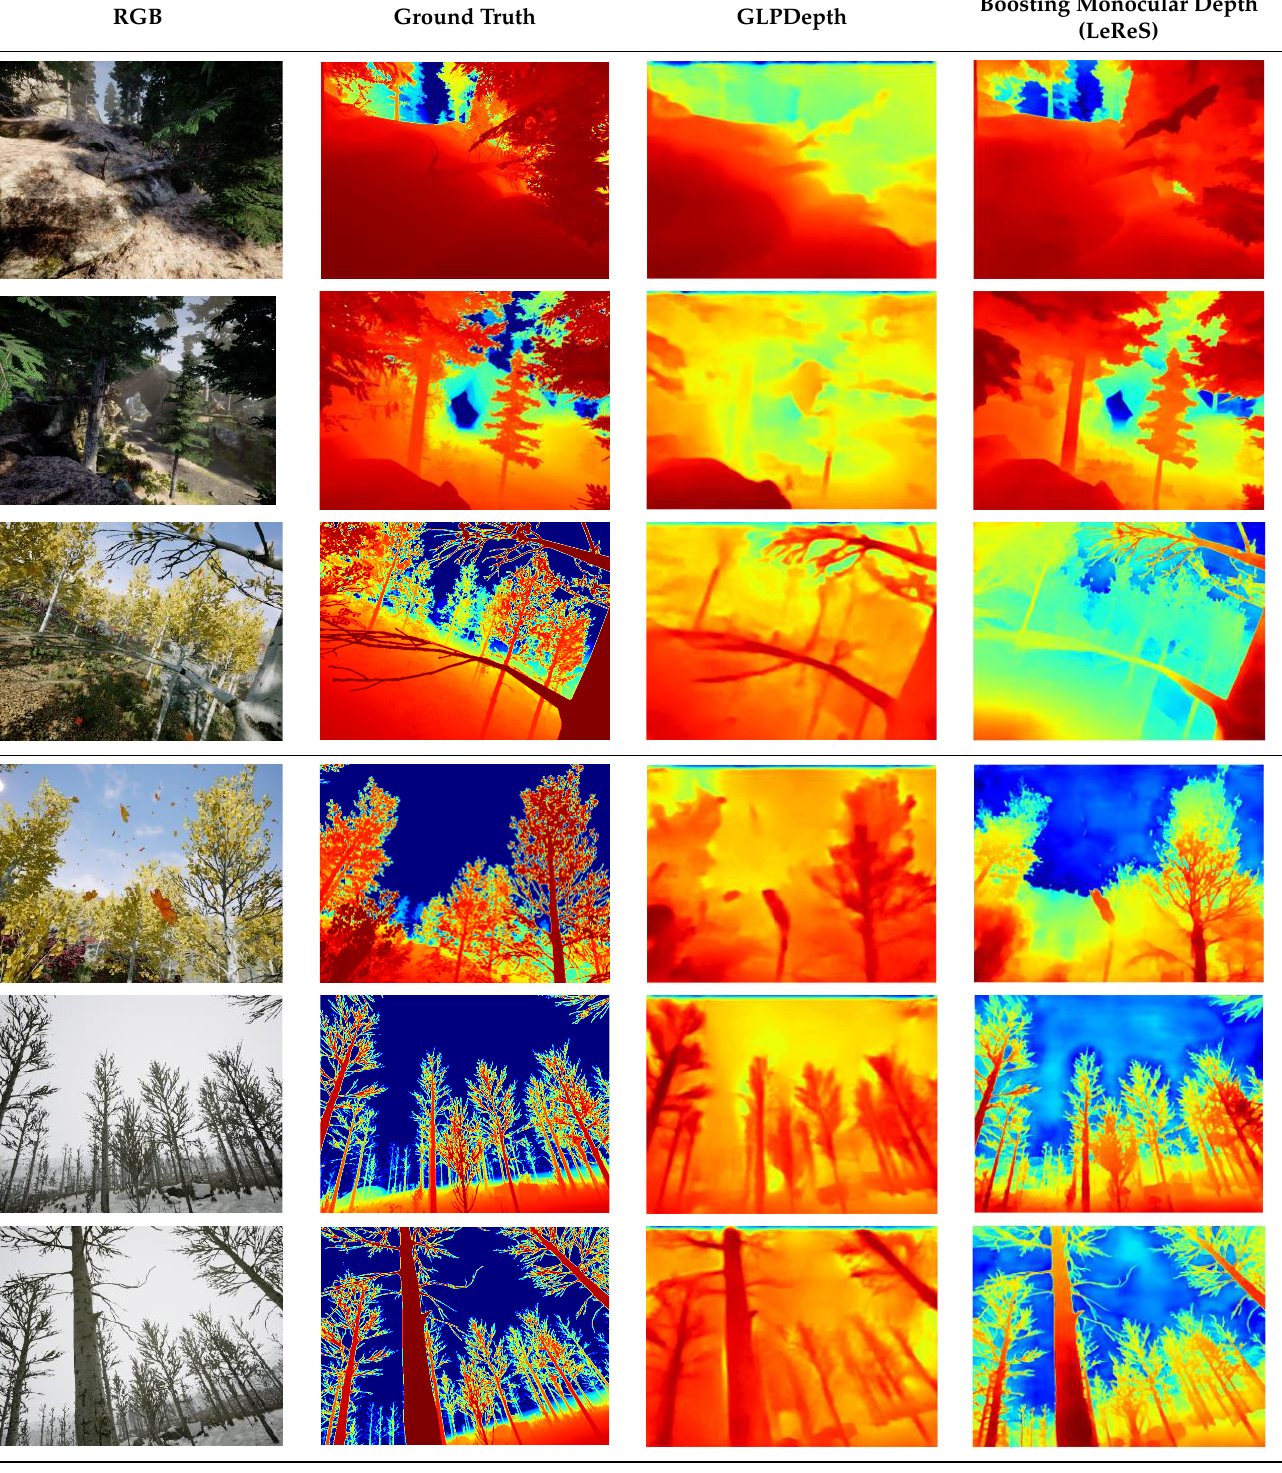
Table 5. Depth maps from GLPDepth and Boosting Monocular Depth (LeReS). RGB